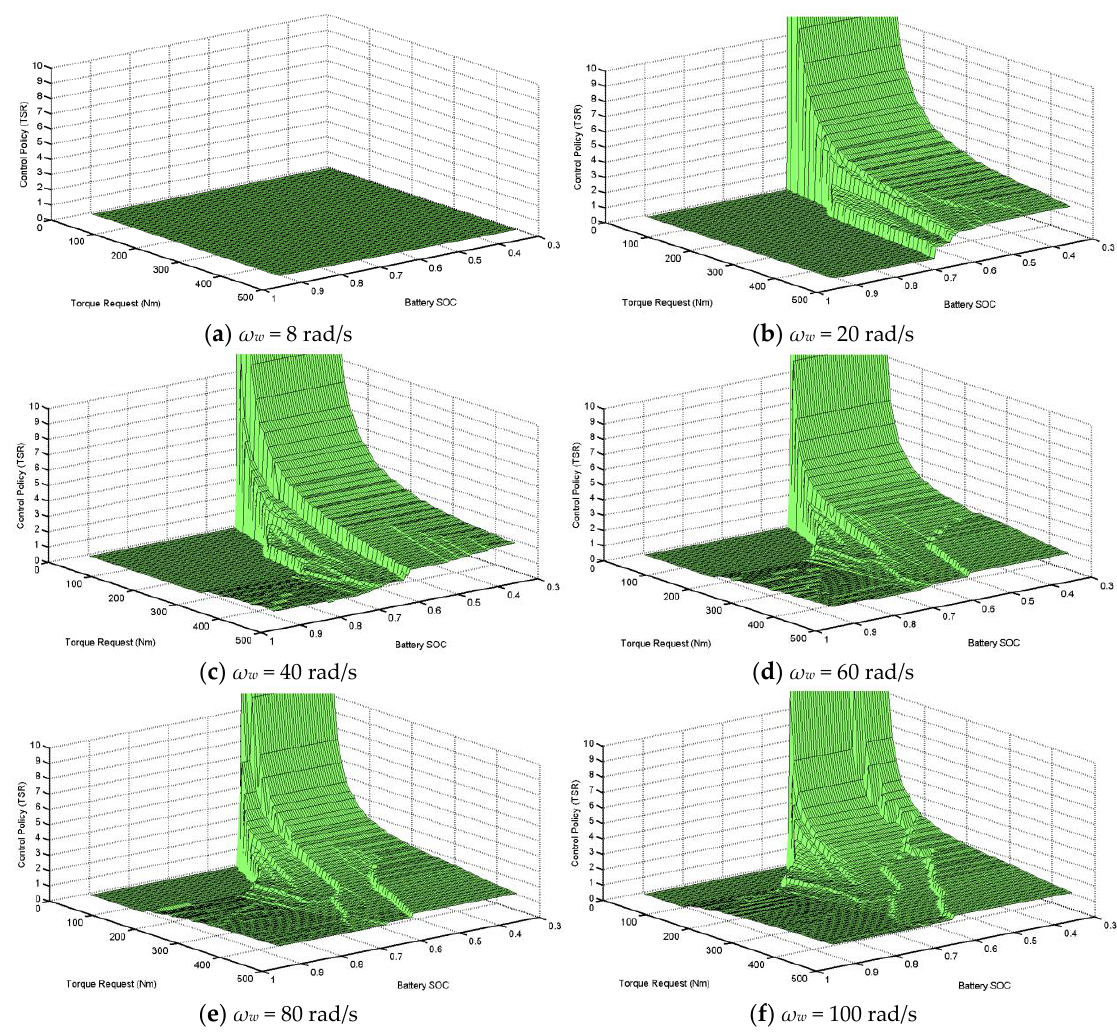
Figure 4. The TSR maps for SDP EMS under UDDS at different driving wheel angular speed, ω w .